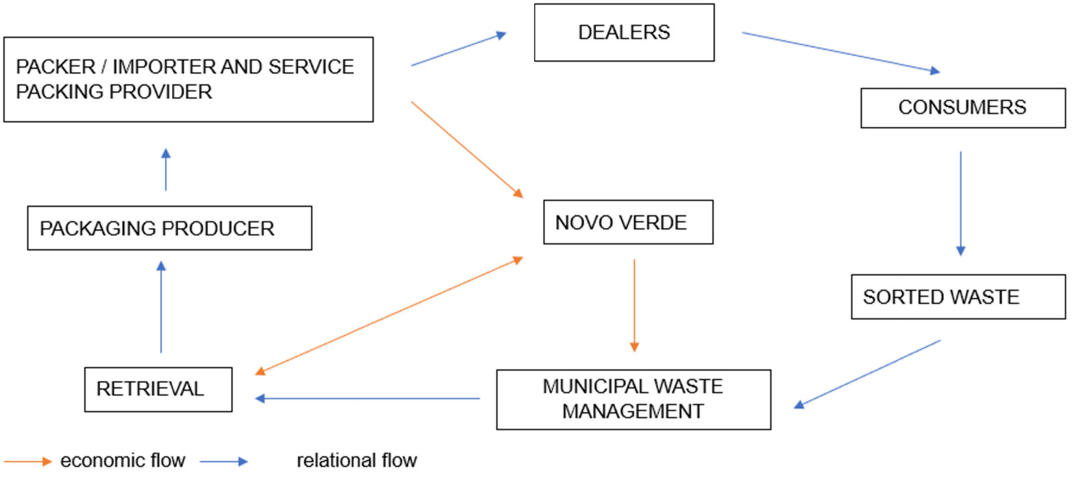
Figure 5. Portuguese model. Source: own elaboration based on [35].